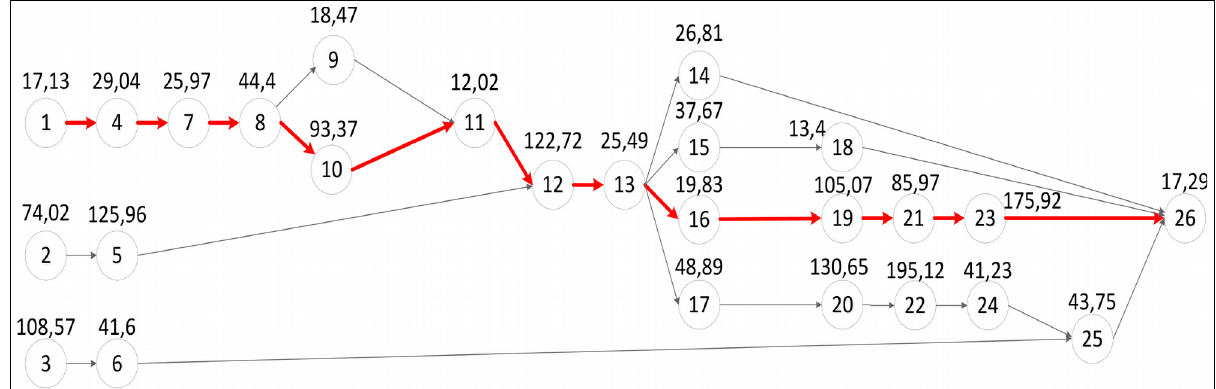
Figure 11. The AON for the PHB-TR 252 Assembly Process Using Two Additional Worker for Particular Work Element (Rmax =